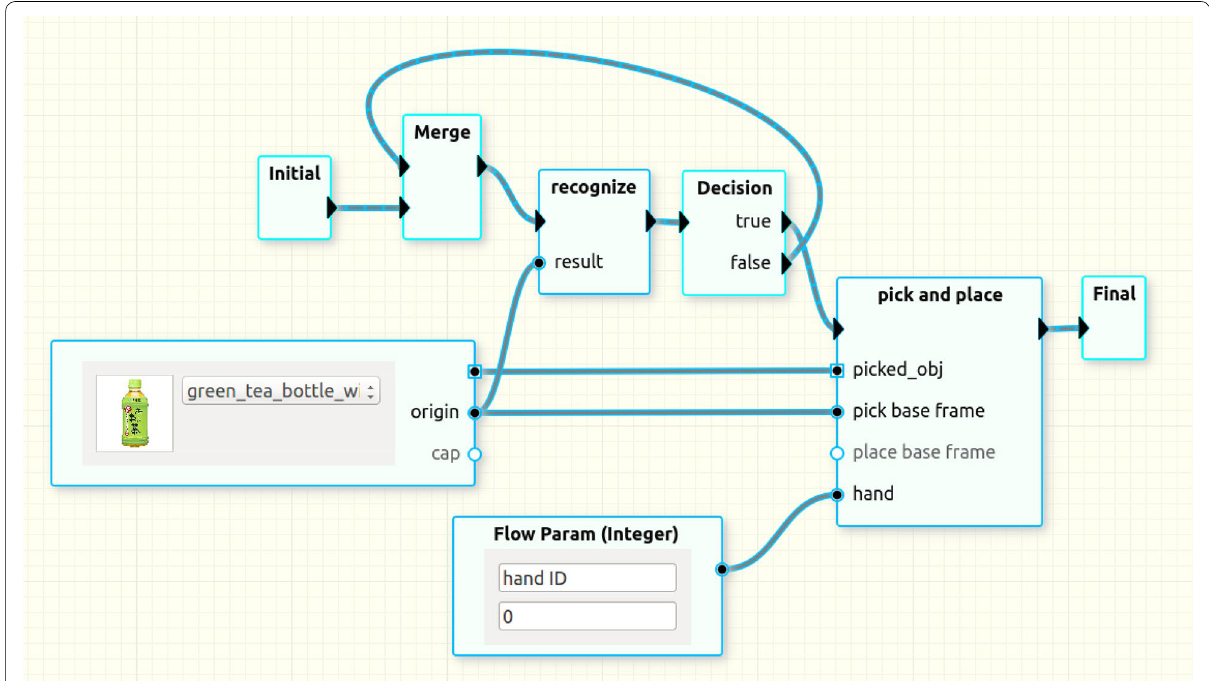
Fig. 3 An example of